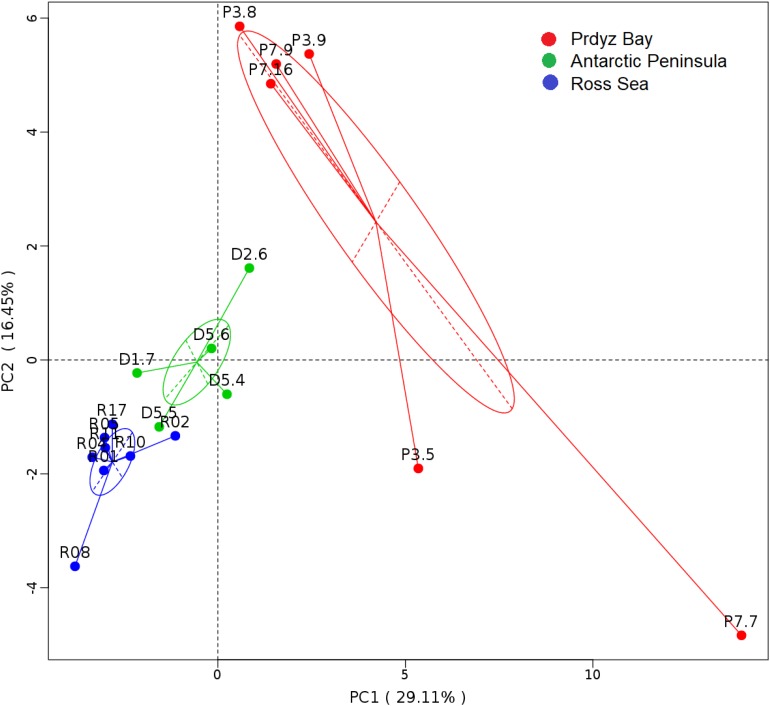
Principal coordinate analysis plots. The first principal coordinate (PC1) clearly separate samples by the location from which they were collected, as indicated by the ovals around pooled samples from the same collection site.